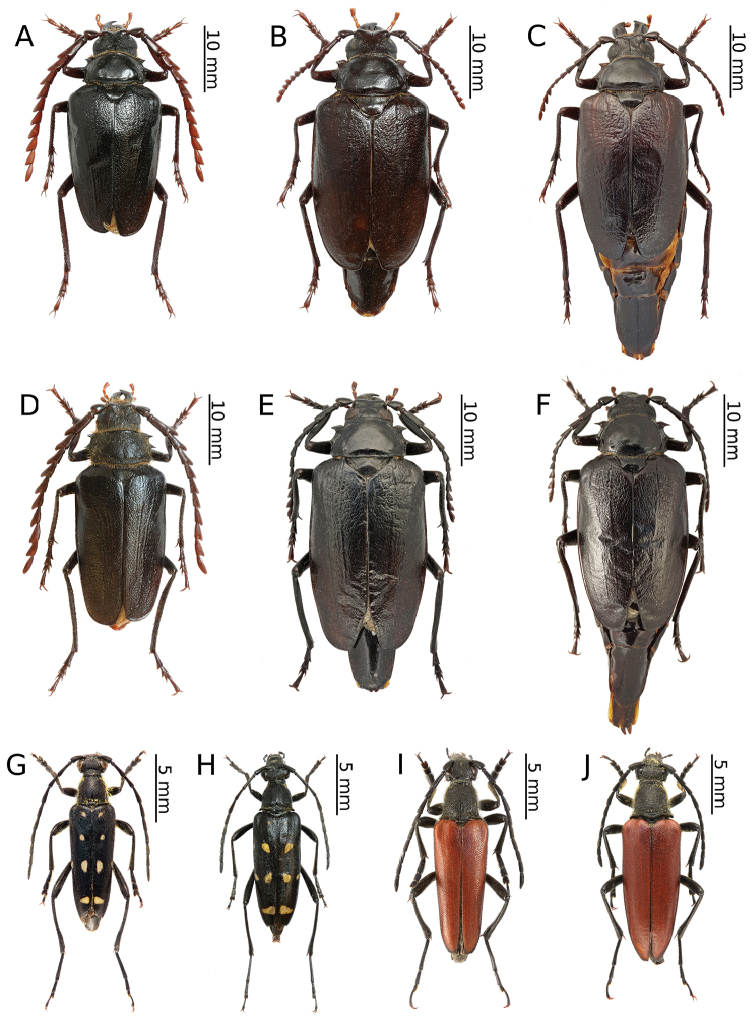
Photos of longhorn beetles specimens collected during the expedition to Kazakhstan in 2017: APsilotarsusbrachypterusbrachypterus (male) BP.brachypterusbrachypterus (female) CP.brachypterusbrachypterus (female, abdomen filled with eggs) DP.brachypteruspubiventris (male) EP.brachypteruspubiventris (female) FP.brachypteruspubiventris (female, abdomen filled with eggs) GLepturaduodecimguttata (male) HL.duodecimguttata (female) ILepturalianigripesrufipennis (male) JL.nigripesrufipennis (female).